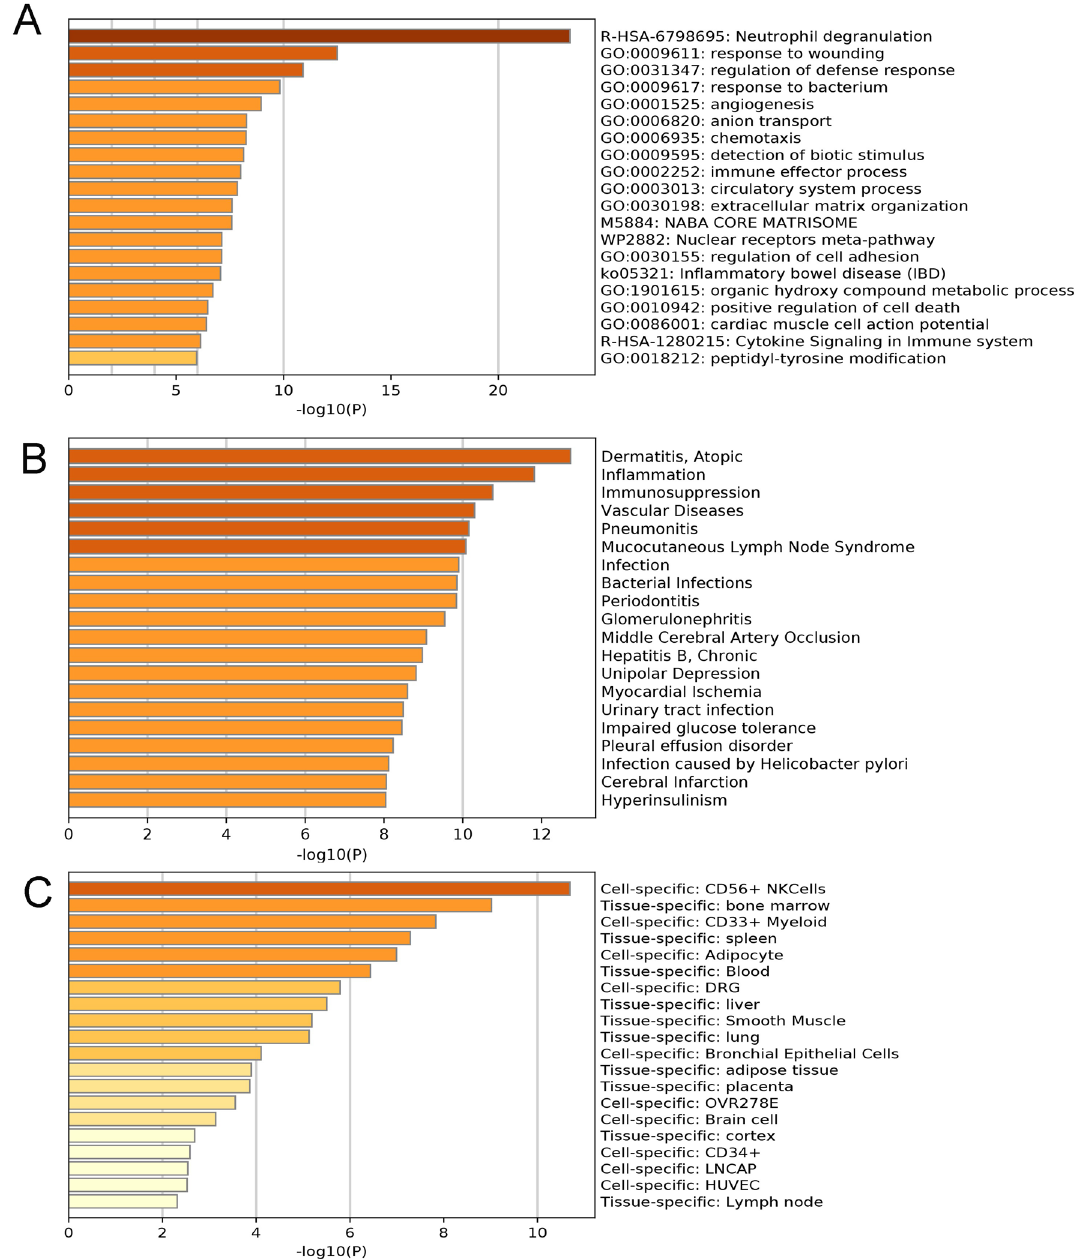
Figure 3. Enrichment analysis of DEGs via the Metascape database. ( A ) Biological processes associated with the DEGs between septic patients and healthy controls. ( B ) Diseases that may be associated with the DEGs. ( C ) Cell- or tissue-specific distribution of the DEGs. DEGs differentially expressed